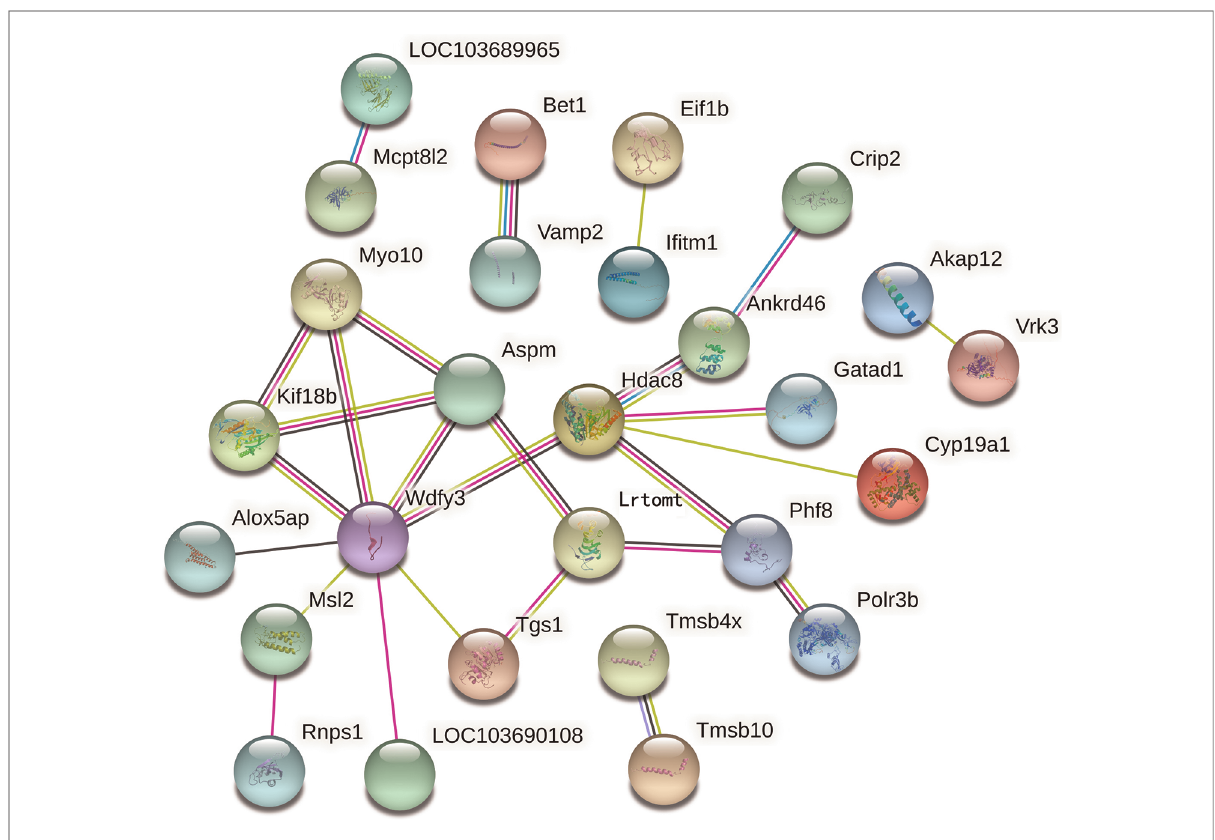
FIGURE 4 Key proteins in the protein – protein interaction network in the OVX+EX and OVX groups.